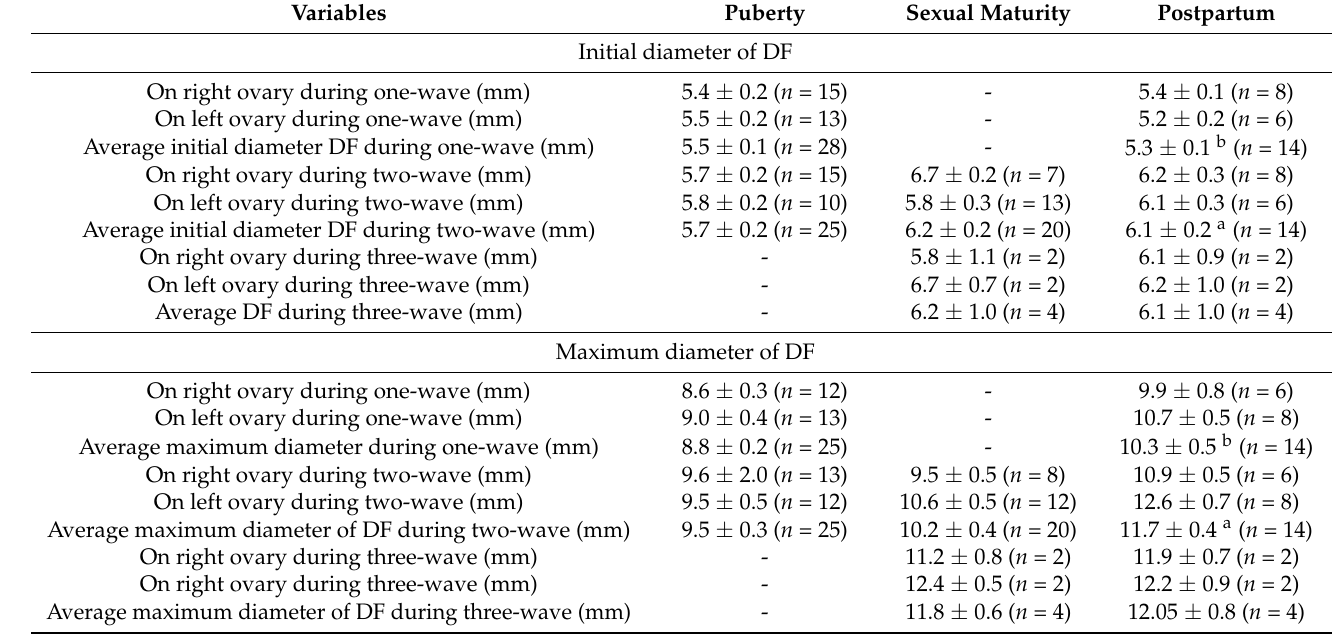
Table 3. The initial and maximum diameter of dominant follicle (DF) during estrous cycle of